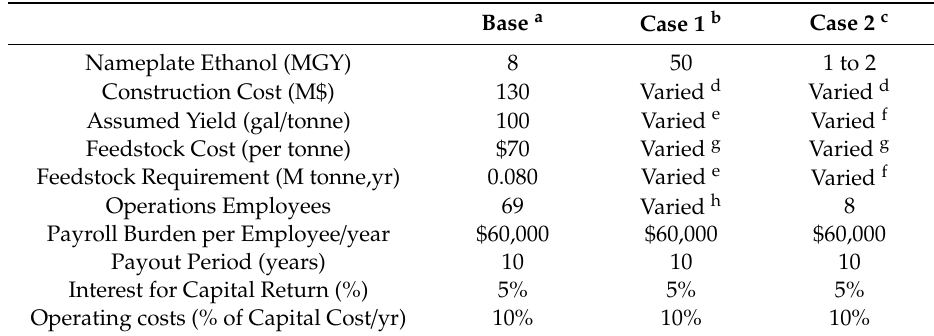
Table 2. Summary of assumptions for cost estimation of the two